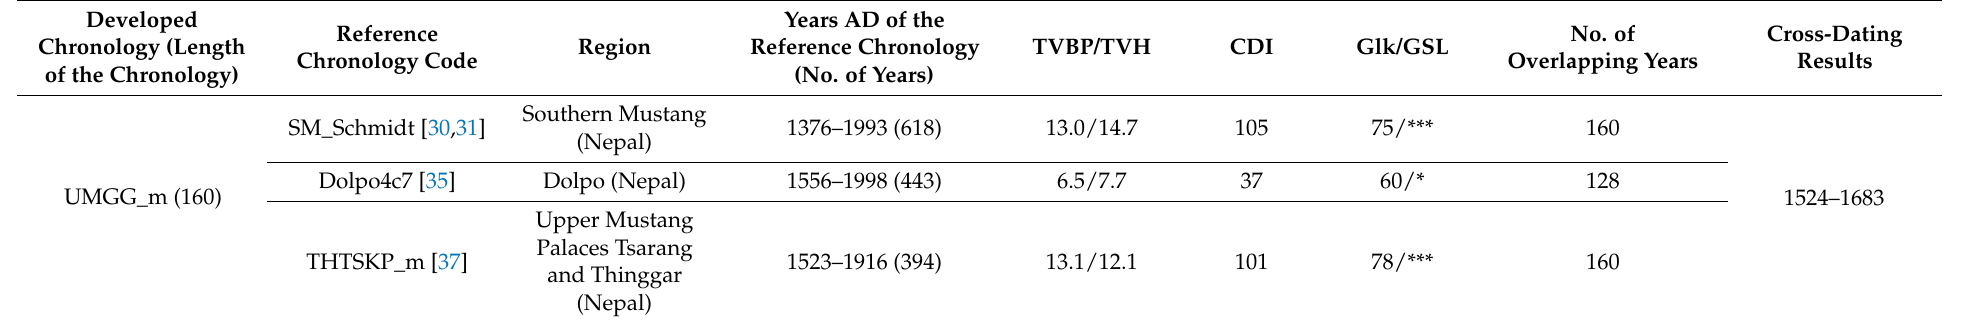
Table 3. Cross-dating results of the developed chronology, UMGG_m, against the reference chronologies. The parameters used for the statistical evaluation of the cross-dating results were: the Gleichläufigkeit (Glk) score, showing the level of agreement between consecutive ring width slopes; GSL: signature Glk